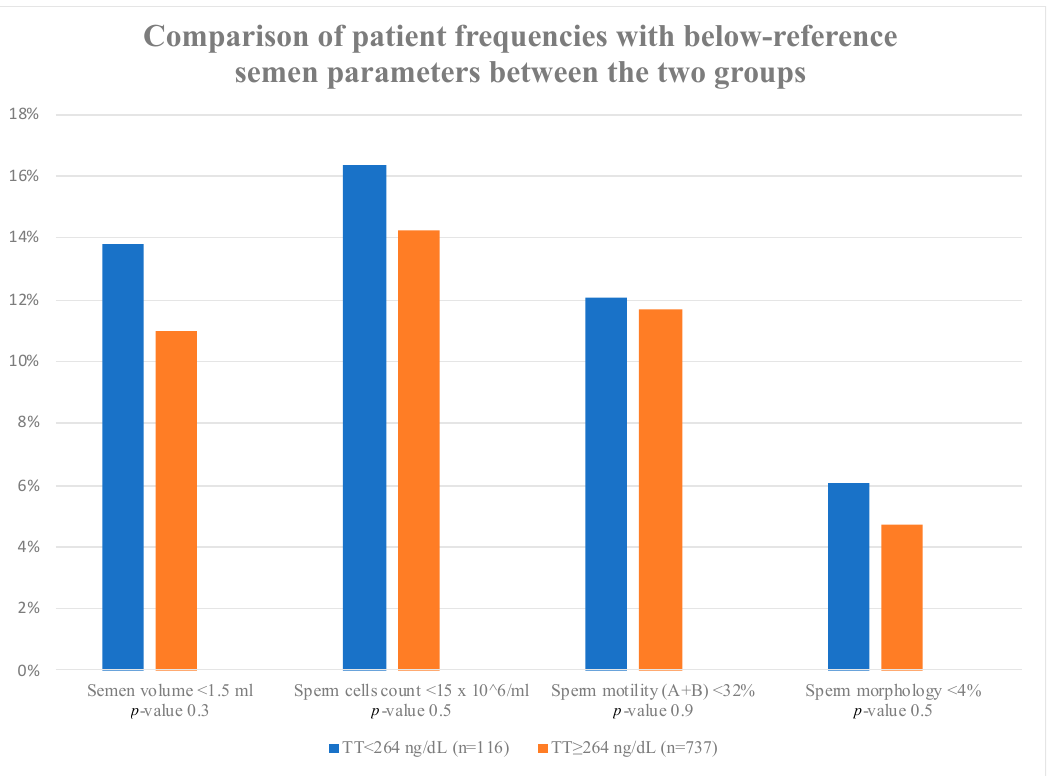
Figure 1. Values are expressed as percentages (%). The p -values were calculated using chi-squared test. n = number; TT = total testosterone. Semen volume (mL) > 1.5 mL = 16 (13.79%) in TT < 264 ng / dL vs.